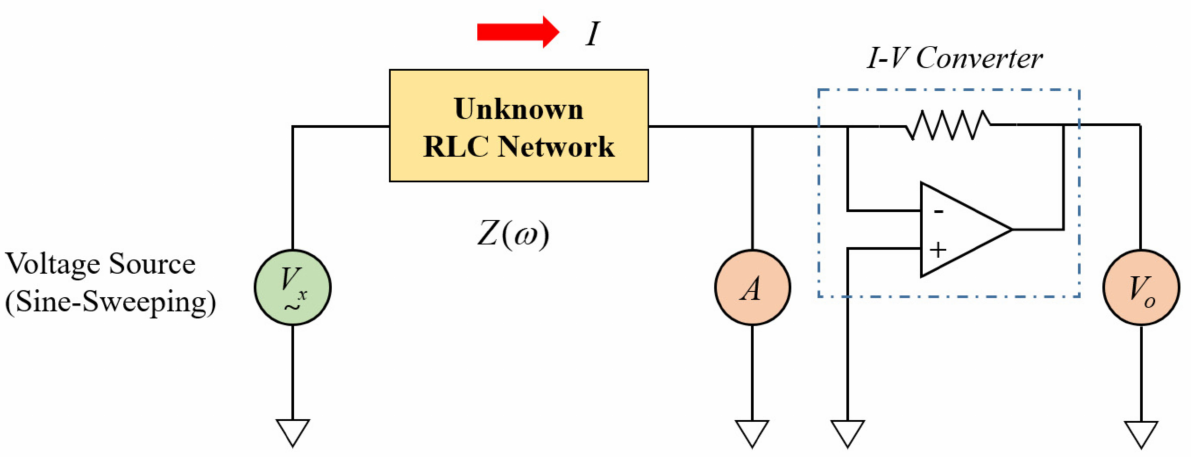
Figure 8. Diagram of an auto-balancing bridge